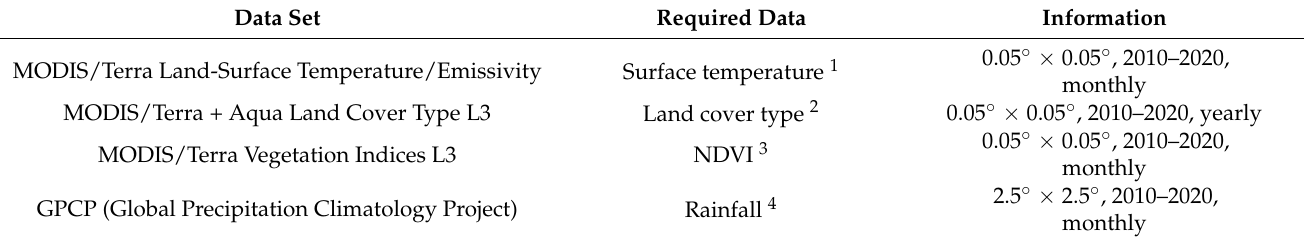
Table 1. Data used to estimate CH 4 emissions in this